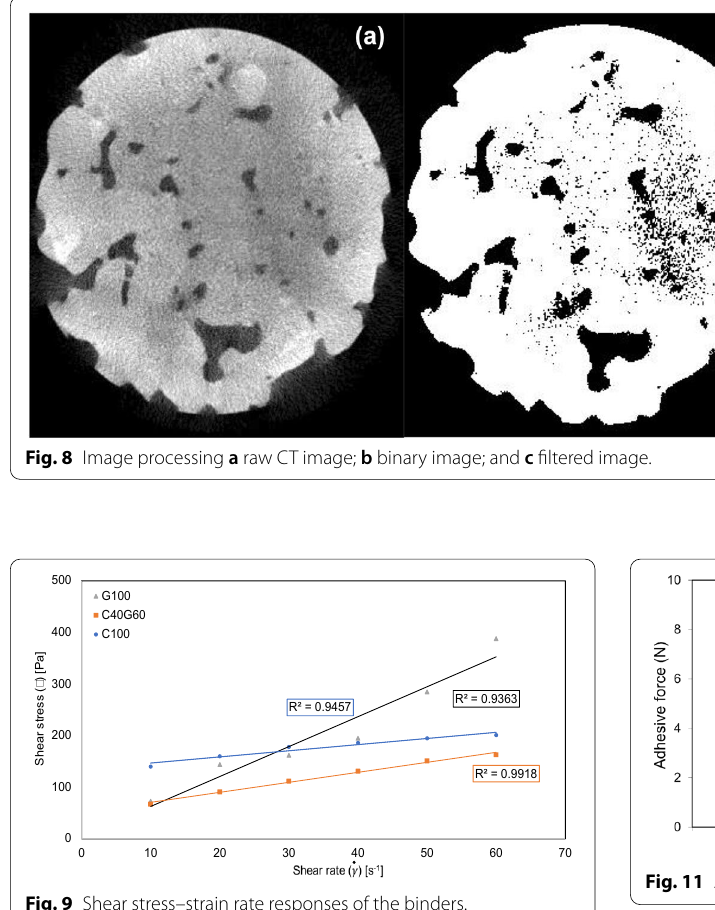
Fig. 9 Shear stress–strain rate responses of the binders.